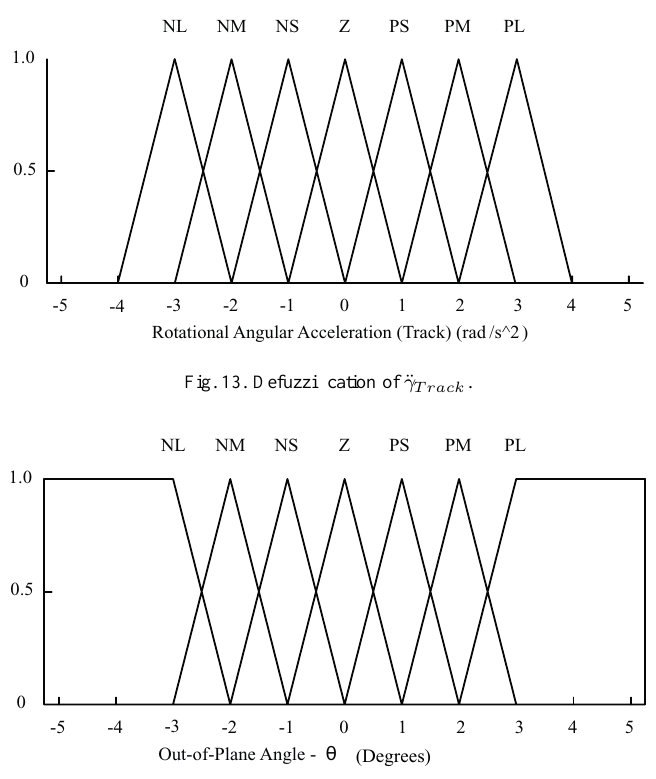
Fig. 14. Fuzzification of θ ( t )